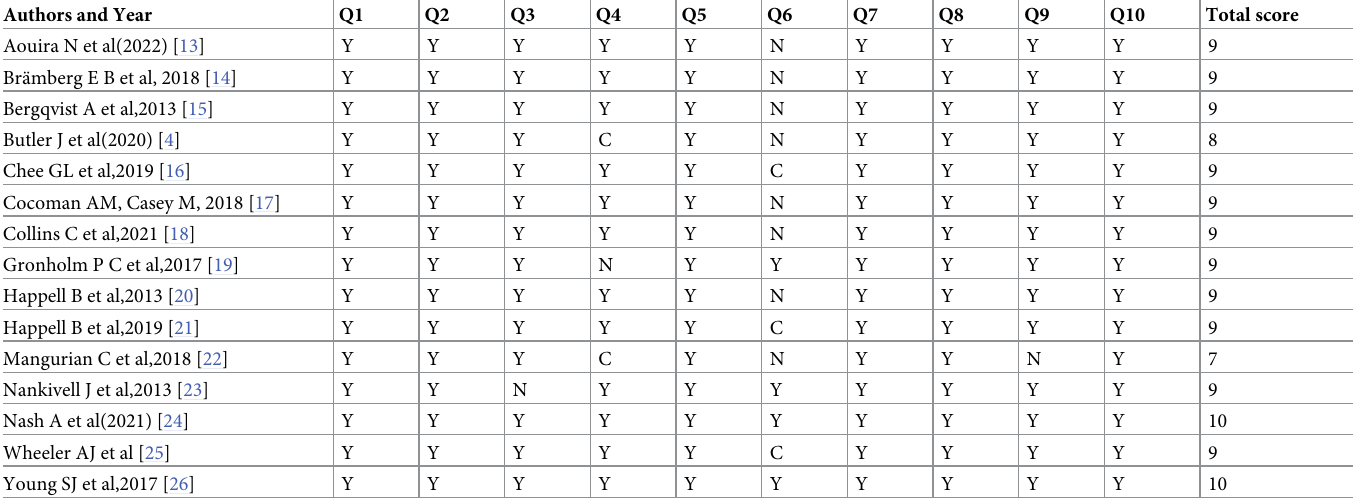
Table 2. Quality appraisal of the eligible studies using